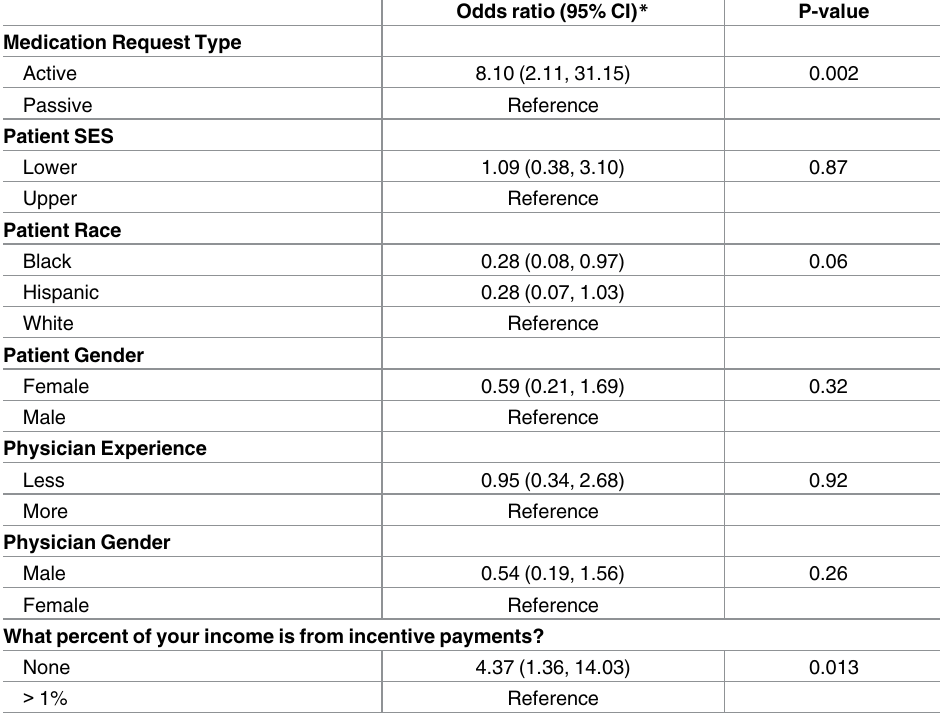
Table 3. Final multivariable model predicting a diagnosis of drug-seeking for the sciatica